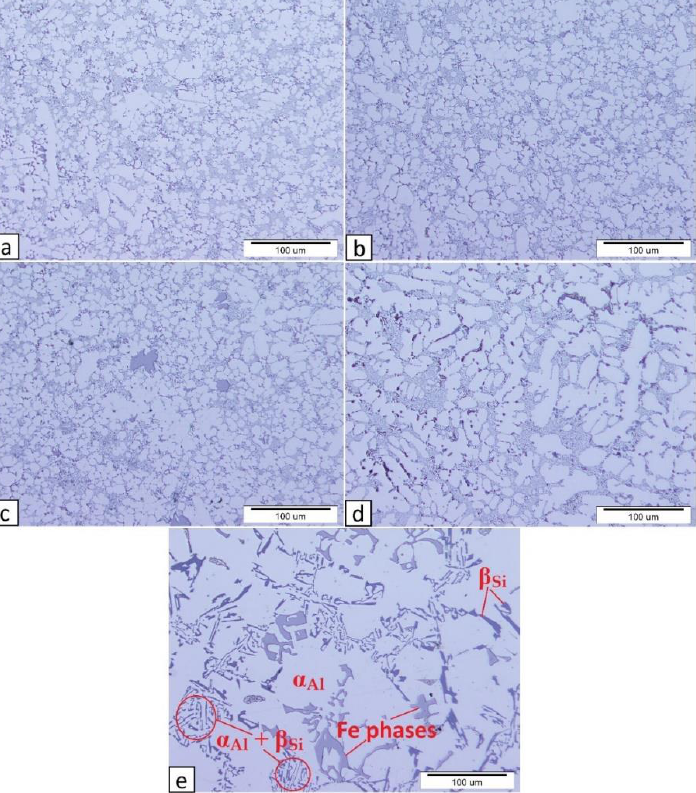
Figure 5. Microstructures of samples: ( a ) 3 mm sample, ( b ) 4 mm sample, ( c ) 6 mm sample from high-pressure die cast (HPDC) casting No. 1, ( d ) the gravity die cast (GDC) sample, and ( e ) the gravity sand cast (GSC) sample cast simultaneously with the casting No.1 production cycle.